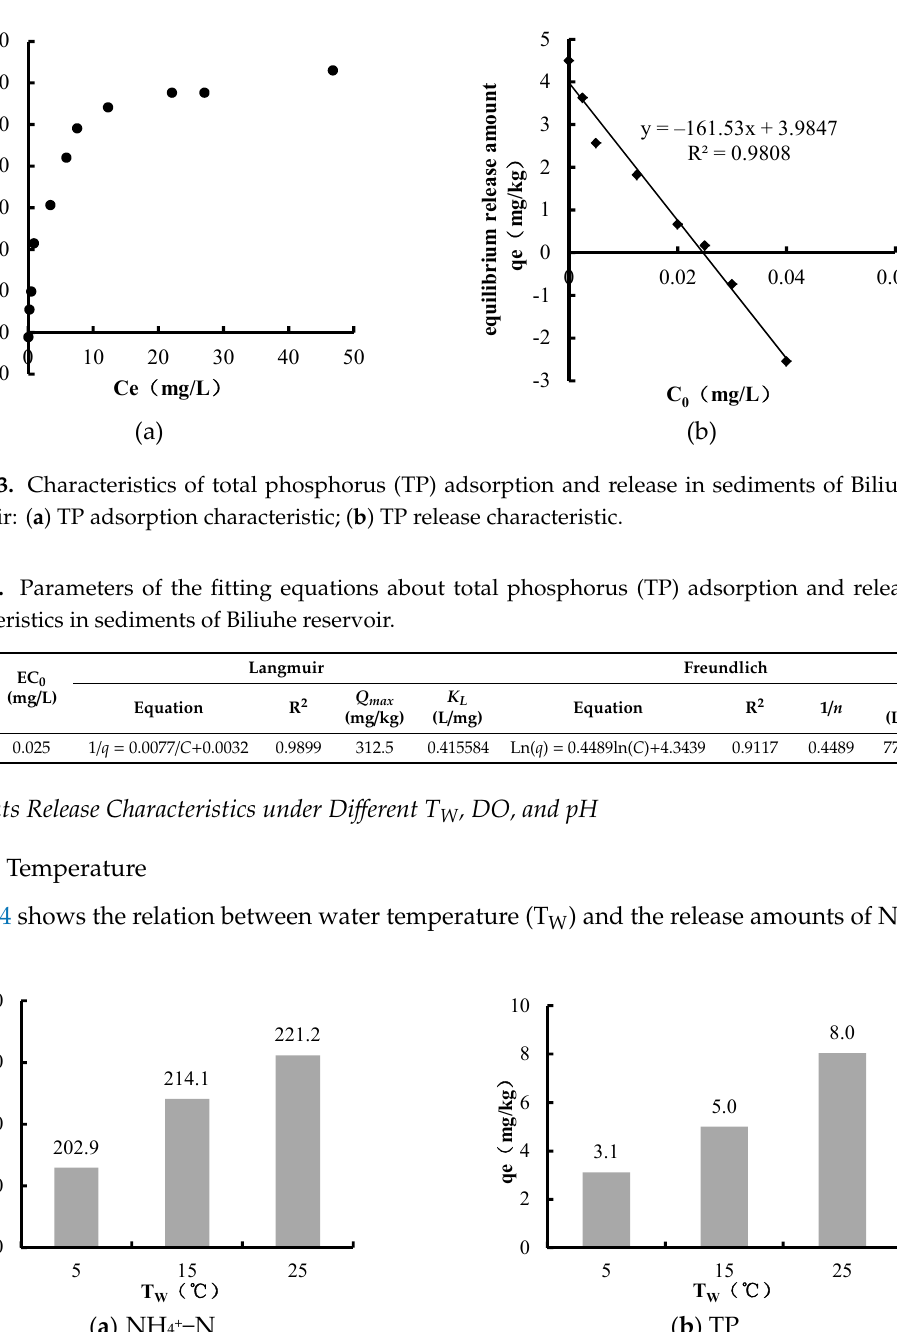
Figure 4. The relation between T W and the release amounts of NH 4+ –N and TP in Biliuhe reservoir.